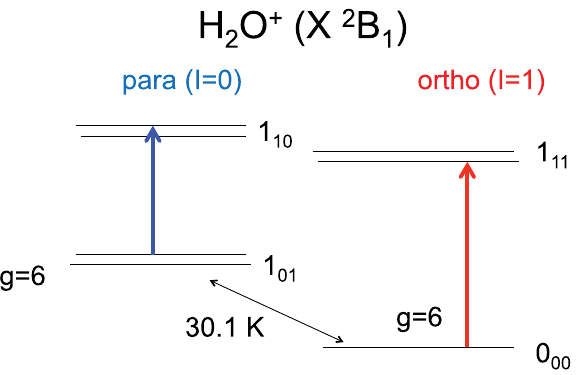
Figure 2. The lowest rotational states of the water cation in its ground electronic state divided into ortho and para groupings. Note that the fine and hyperfine structure lead to nearly degenerate groups of 6 states (g = 6) for the lowest rotational states. The arrows show some detected rotational transitions in diffuse interstellar clouds, where excited rotational states are likely not populated due to the low density of the gas. The 30.1K refers to the energy difference between the lowest ortho and para